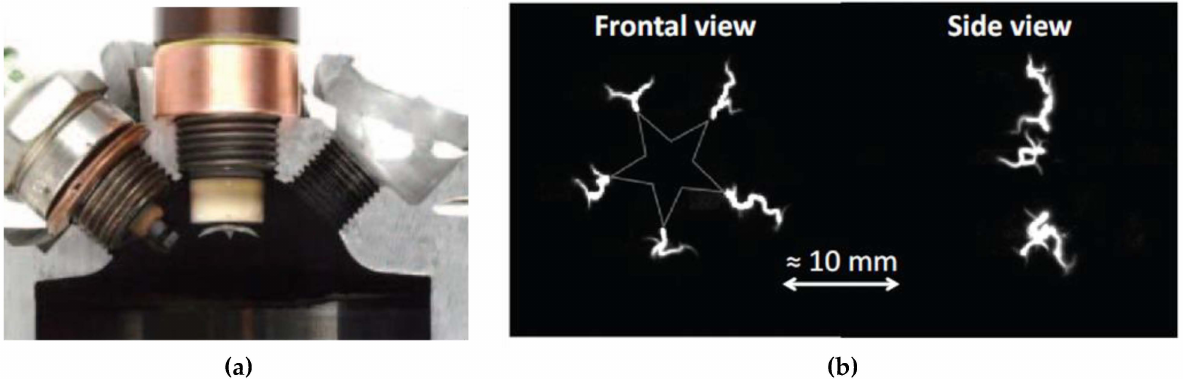
Figure 8. Images of ( a ) the corona igniter and ( b ) the combustion initiation of the conventional spark plug and corona igniter